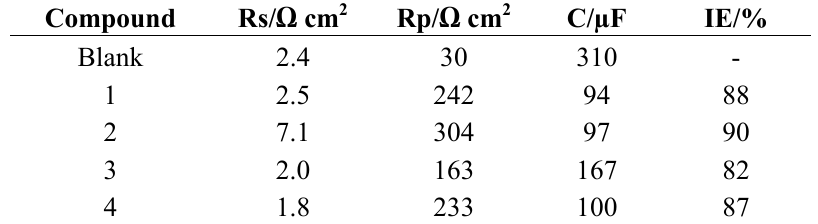
Table 3. Electrochemical parameters obtained from experimental impedance data, see Figure 1, including the corrosion inhibition efficiencies,